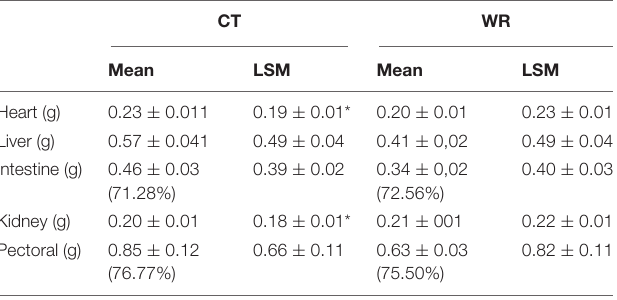
Asterisk denotes significant differences in LSM between experimental groups after an ANCOVA (see Supplementary Table 1B for details). The mean percentage of water for intestine and pectoral muscle are provided in parentheses.